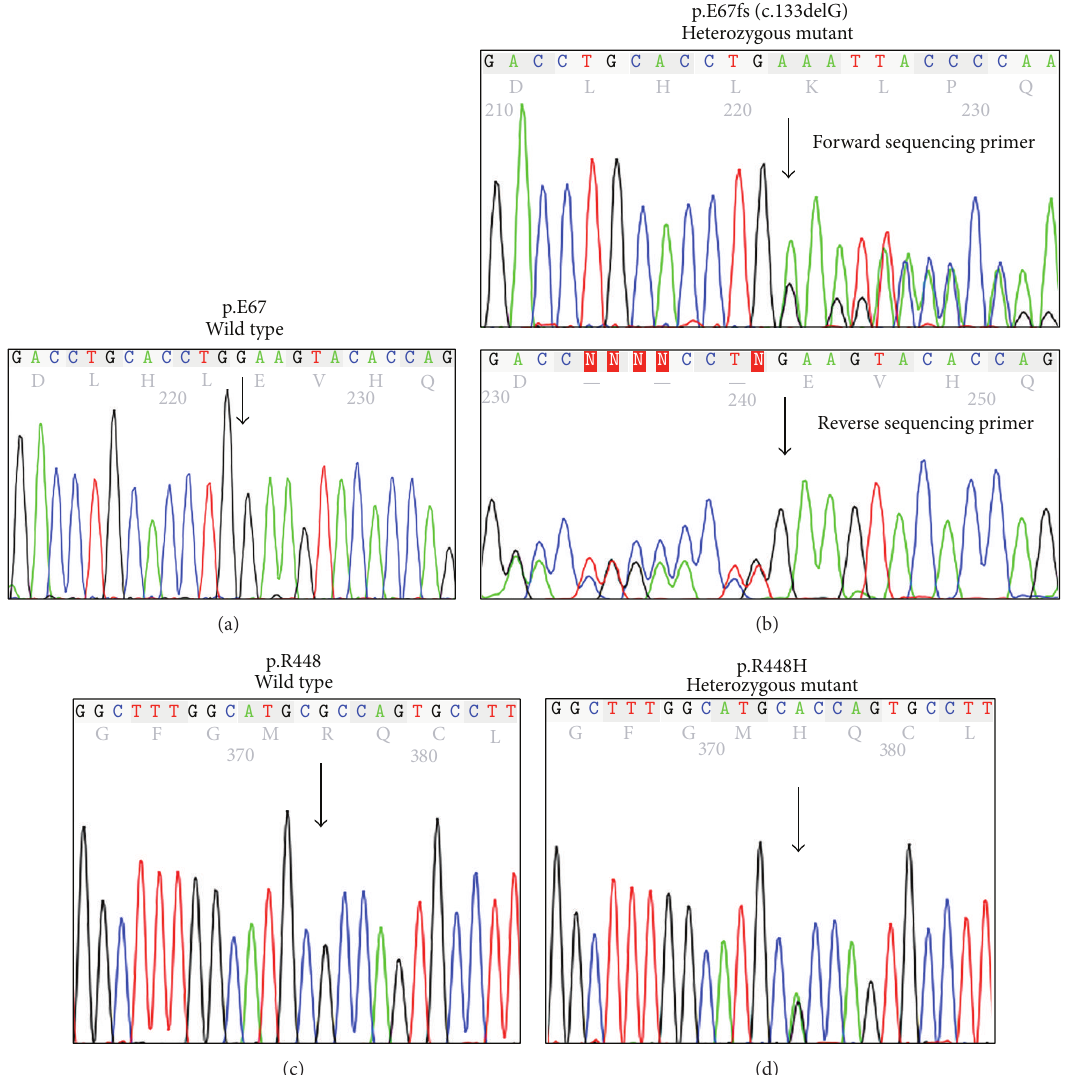
Figure 1: Sequencing electropherograms showing CYP11B1 mutations in Patient 1. Wild-type CYP11B1 DNA sequences encoding p.E67 (a) and p.R448 (c) from a normal individual are shown as reference. Patient 1 is compound heterozygous for a novel exon 1 p.E67fs (c.199delG) frameshift mutation on one allele (b) and an exon 8 p.R448H mutation on the other allele (d) of the CYP11B1 gene. Patient 2, the younger brother of Patient 1, carries identical